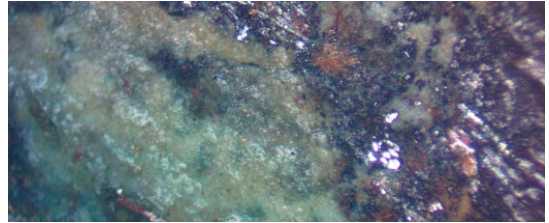
Figure 5. ST Trial Pellet (ST1b [16]) Following Desalination: Reflected Light; Halite mass infilling and expanding porosity. Field of View = 0.937 mm.